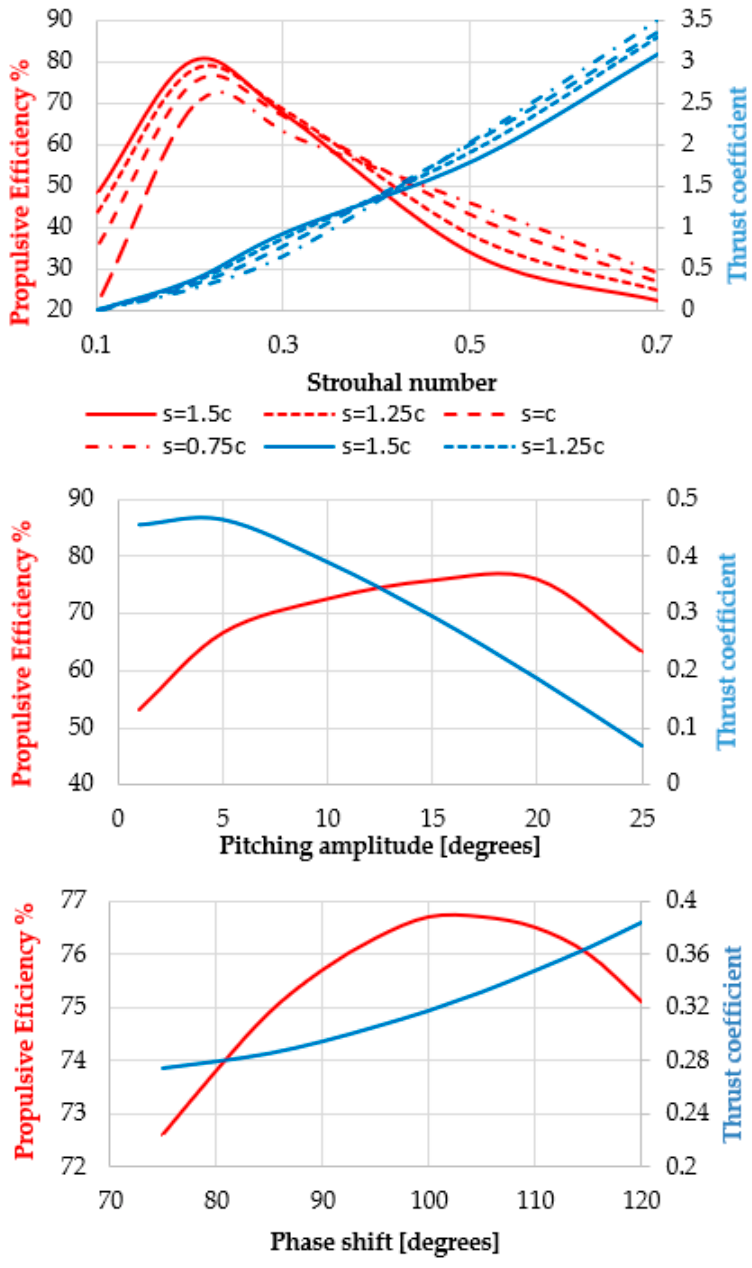
Figure A2. Results of the sensitivity analysis of the propulsive efficiency and the thrust coefficient from the translation and rotation amplitude, plus the phase difference between the pitching and heaving components of the roto-translation (the translation amplitude s is expressed as a multiple of foil chord c ).